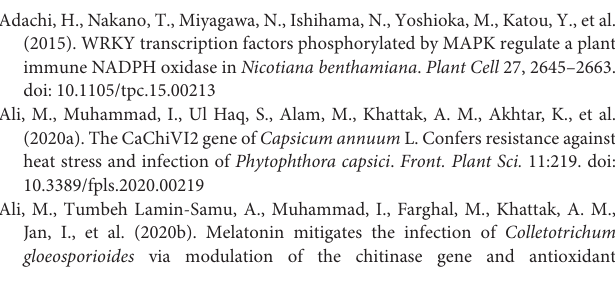
Supplementary Figure 2 | Relative GUS activities driven by the CaMAPK7 promoter in transgenic tobacco plants in response to Ralstonia solanacearum